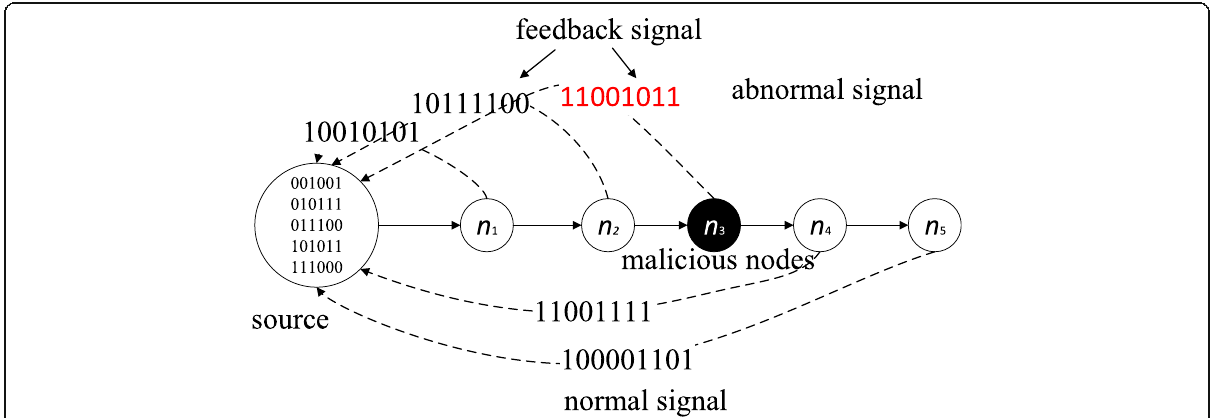
Fig. 4 The feedback signal verifies the consistency between the received data and the transmitted